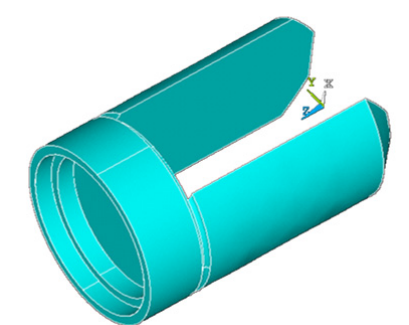
Figure 3. Tuning fork